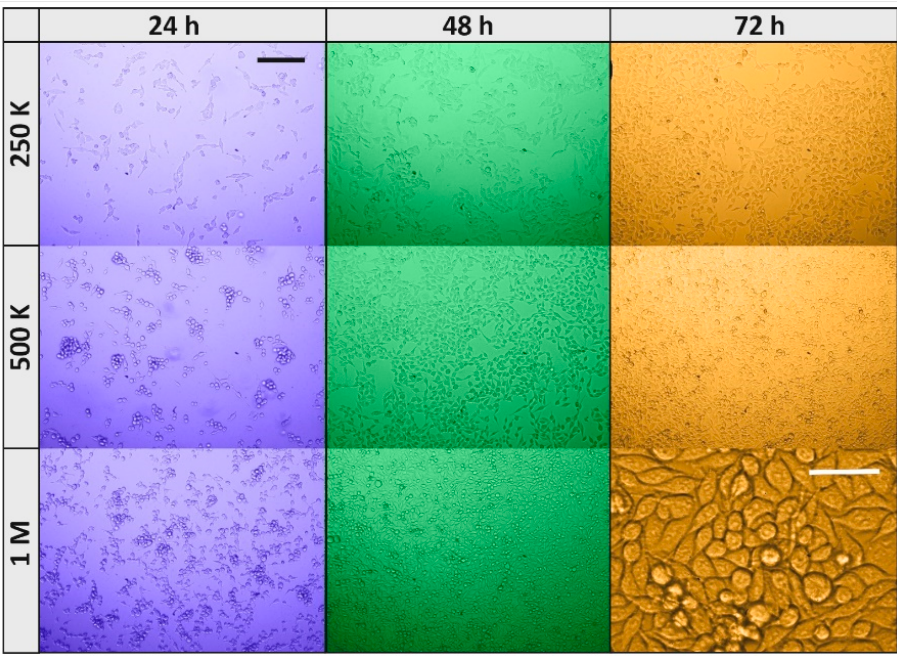
Figure 9. Microphotograph of RKO cells plated at various times of withdrawal from the incubator and at different densities. Cells plated at 250 K, 500 K and 1 M cells/dish withdrawn from the incubator after 24 h (blue background), 48 h (green), and 72 h (orange); black scale bar is 200, and it applies to all microphotographs, but the white scale bar (50 µm) applies to its microphotograph only. Figure 9 (orange background) shows, at high magnification, the cells plated at 1M after 72 h of plating that had become spherical and granular, a clear indication that they were detaching from the dish bottom and dying. A further reason of the small response at 1 M cells/dish concentration could be a reduced cell growth rate and/or activity due to contact inhibition, and consequently a decrease in VOC exhalation. However, this possibility is excluded, since cancerous cells continue proliferation and growth when they contact each other, leading to uncontrolled cell propagation and solid tumor formation